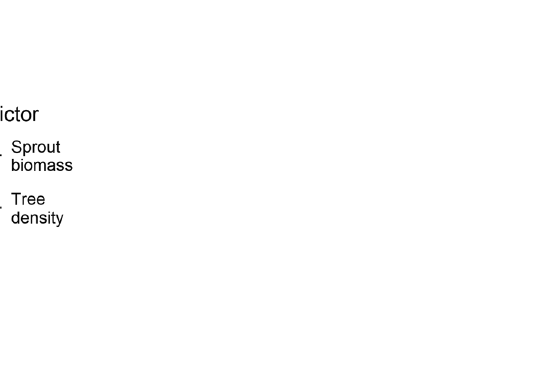
Figure 5. Effects of logging-induced changes in tree density and growth-induced changes in sprout biomass on environmental variables represented by Ellenberg indicator values. All variables were standardized to zero mean and unit variance. Points correspond to slope estimates and lines to 95% confidence intervals. Filled symbols indicate effects with P ≤